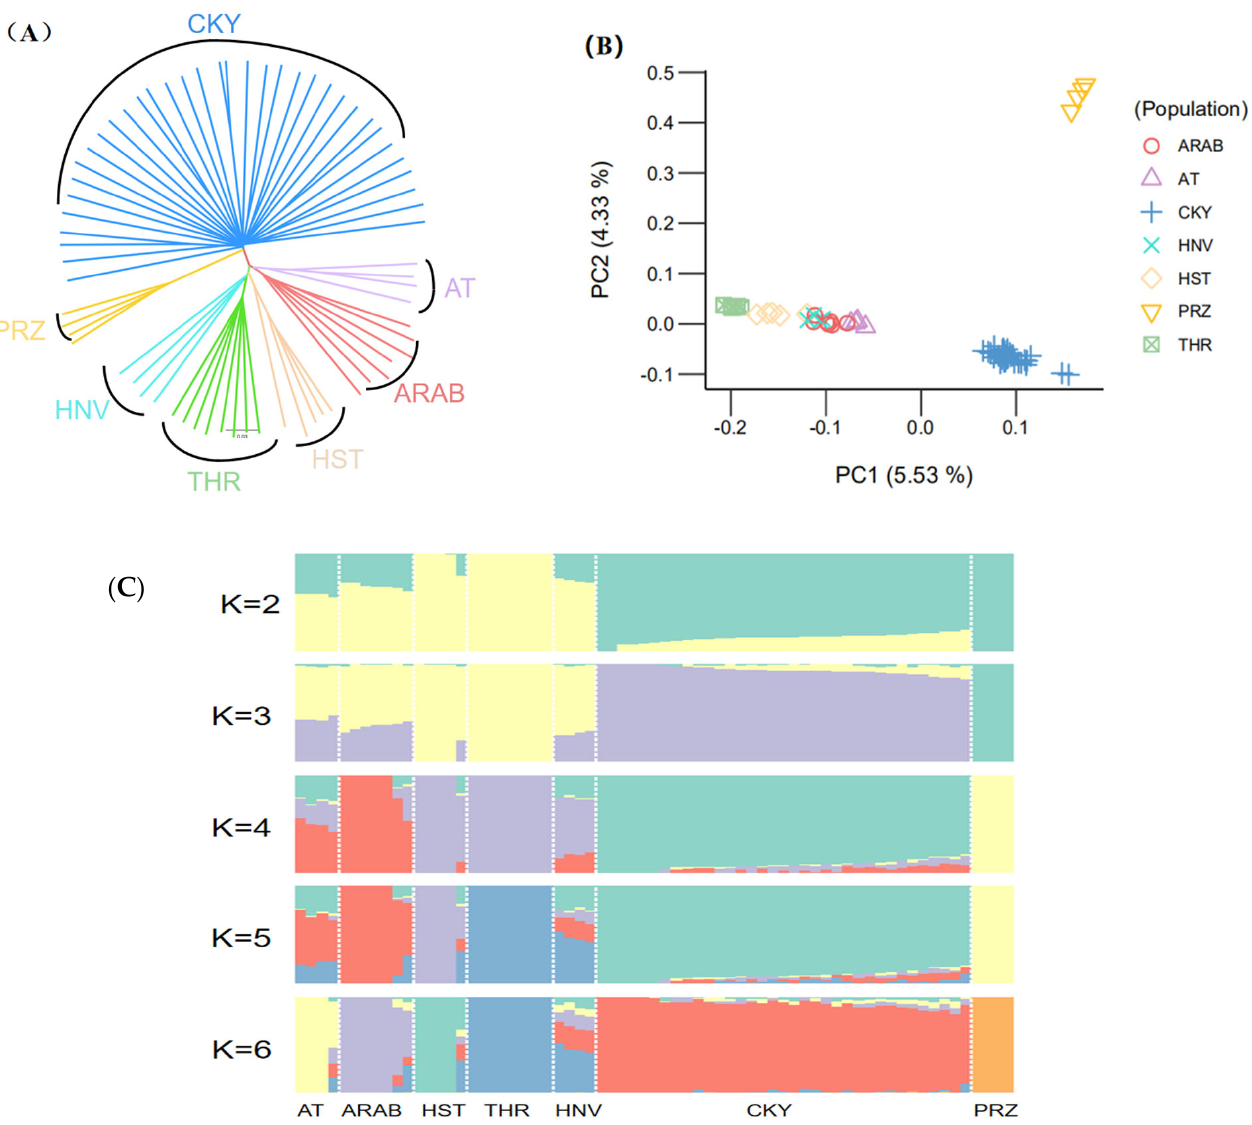
Figure 1. Population genetic relationship between the Chakouyi horse and foreign horse breeds. ( A ) Neighbor-joining tree of the Chakouyi horses and the foreign horses constructed with the genome-resequencing data. The populations studied are indicated with different colors and the names of the breeds. ( B ) PCA results of the Chakouyi horse and foreign horse breeds. The studied horse populations are indicated with different colors. ( C ) ADMIXTURE analysis of the Chakouyi horse and the foreign horse populations. Each column indicates an individual, and each column group represents a horse population. AT, Akhal-Teke horse; Arab, Arabian horse; HST, Holsteiner horse; THR, Thoroughbreds; HNV, Hanoverian horse; CKY, Chakouyi horse; PRZ, Przewalski’s horse.